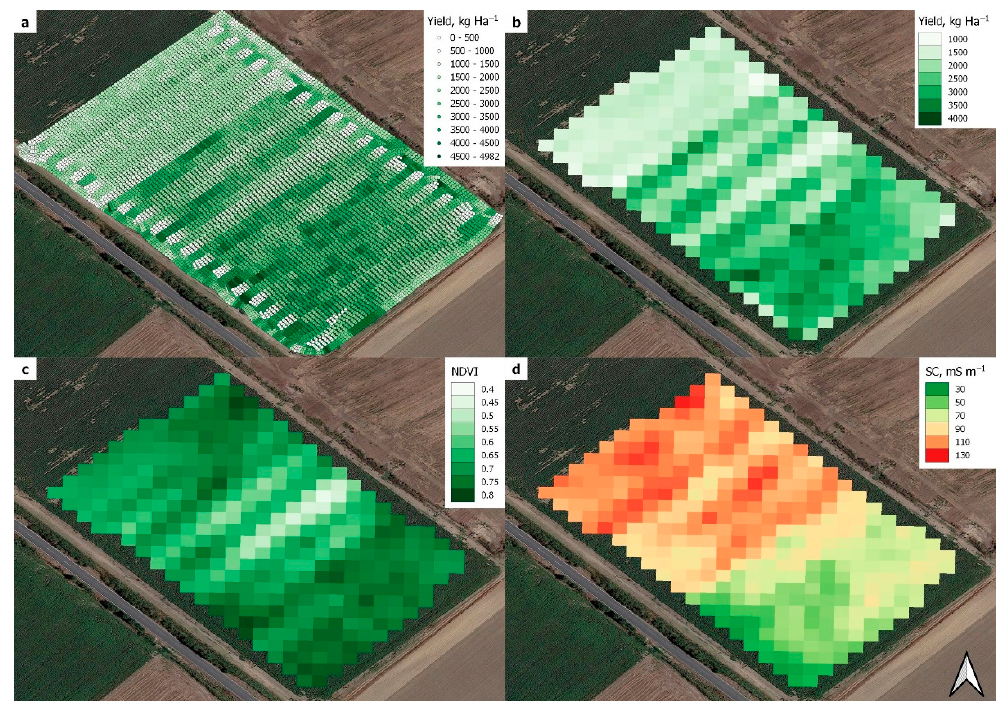
Figure 1. Satellite image of the Thessaly plain, Greece (inset), with the studied fields indicated.